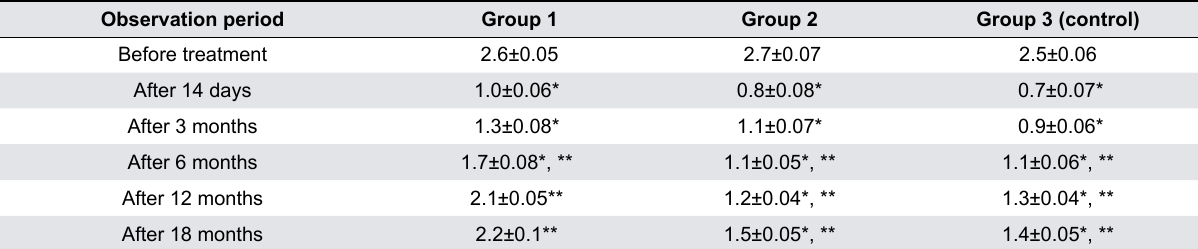
Table 2- The dynamics of the Muhlemann index change in patients with different vitamin D status Observation